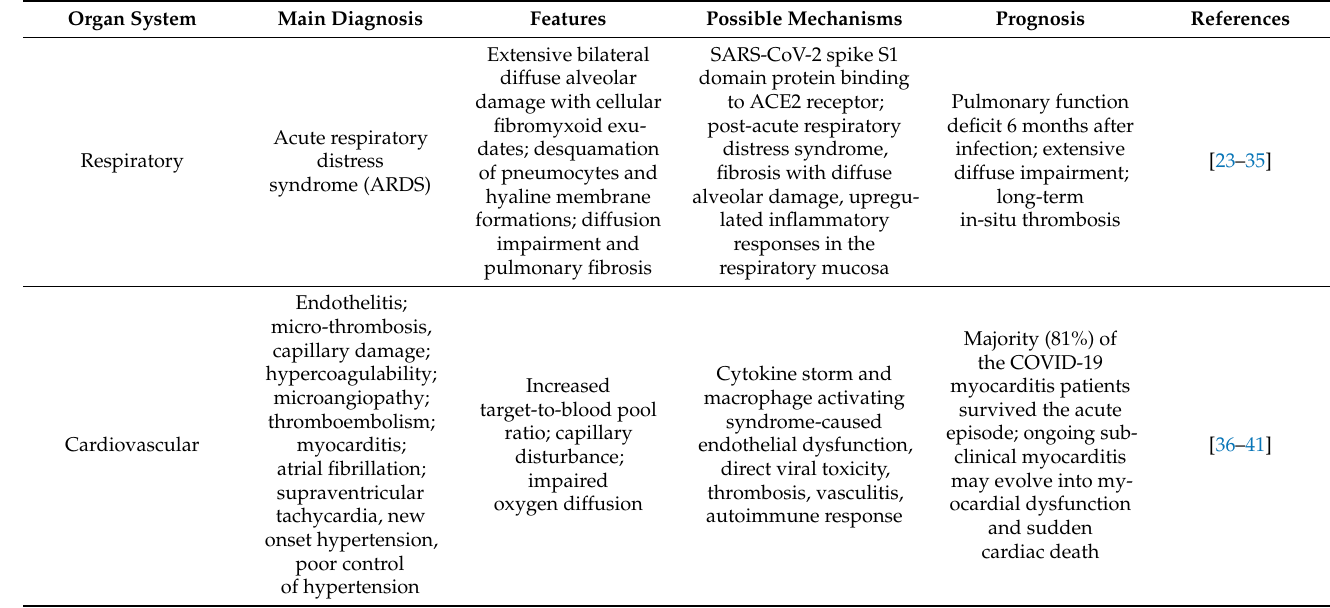
Figure 2. Common clinical presentations of PC19S. (Parts of the Figure was drawn and adapted using pictures from Servier Medical Art (http://smart.servier.com/) (accessed on 10 July 2022), licensed under a Creative Commons Attribution 3.0 Unported License (https://creativecommons. org/licenses/by/3.0/) (accessed on 4 February 2023). Table 1. Summary of PC19S effect on various systems [8], an updated